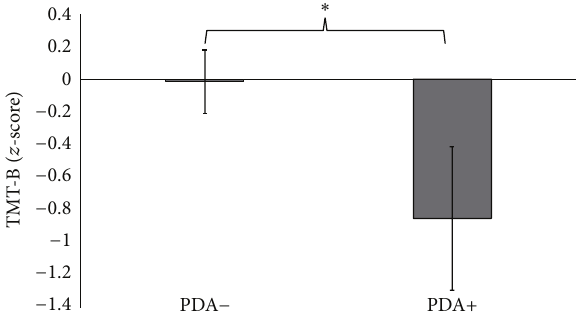
Figure 1: PD patients with anxiety performed significantly worse on Part B of the Trail Making Task compared to PD patients without anxiety. ∗ denotes 𝑝 values < 0.05. Error bars represent standard